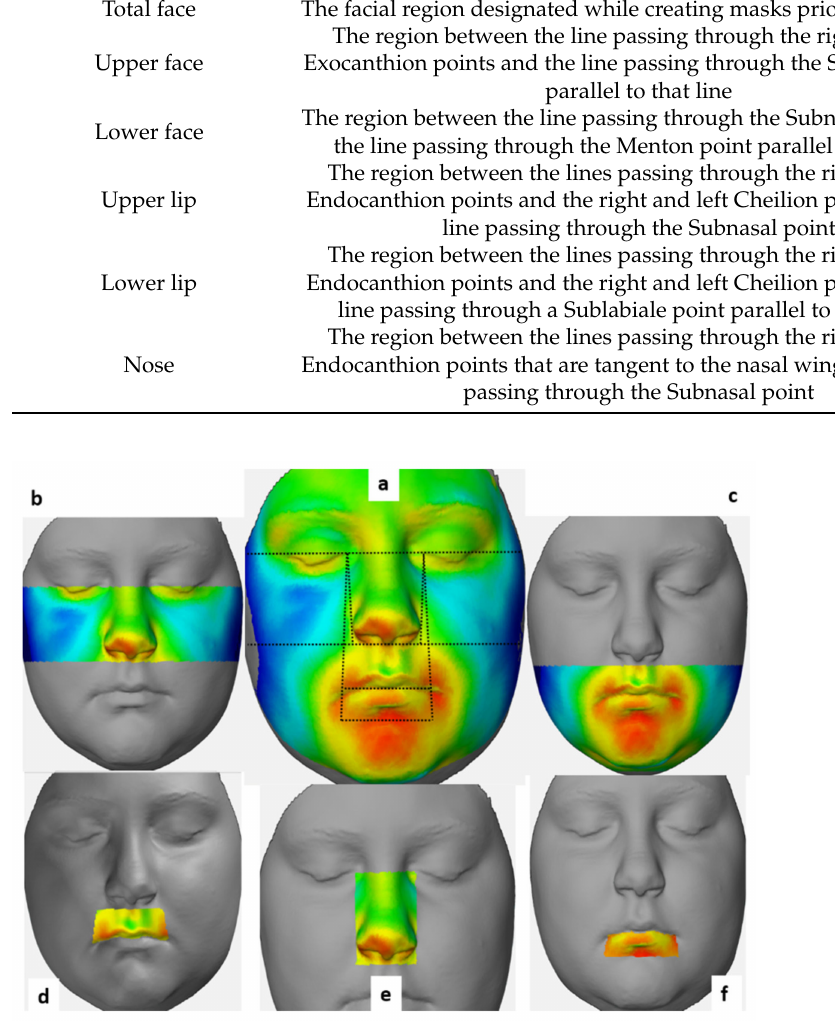
Figure 6. The morphological regions and their reference lines used in our study. ( a ) Total face region with the reference lines used. ( b ) Upper face region. (c) Lower face region. ( d ) Upper lip region. ( e ) Nose region. ( f ) Lower lip